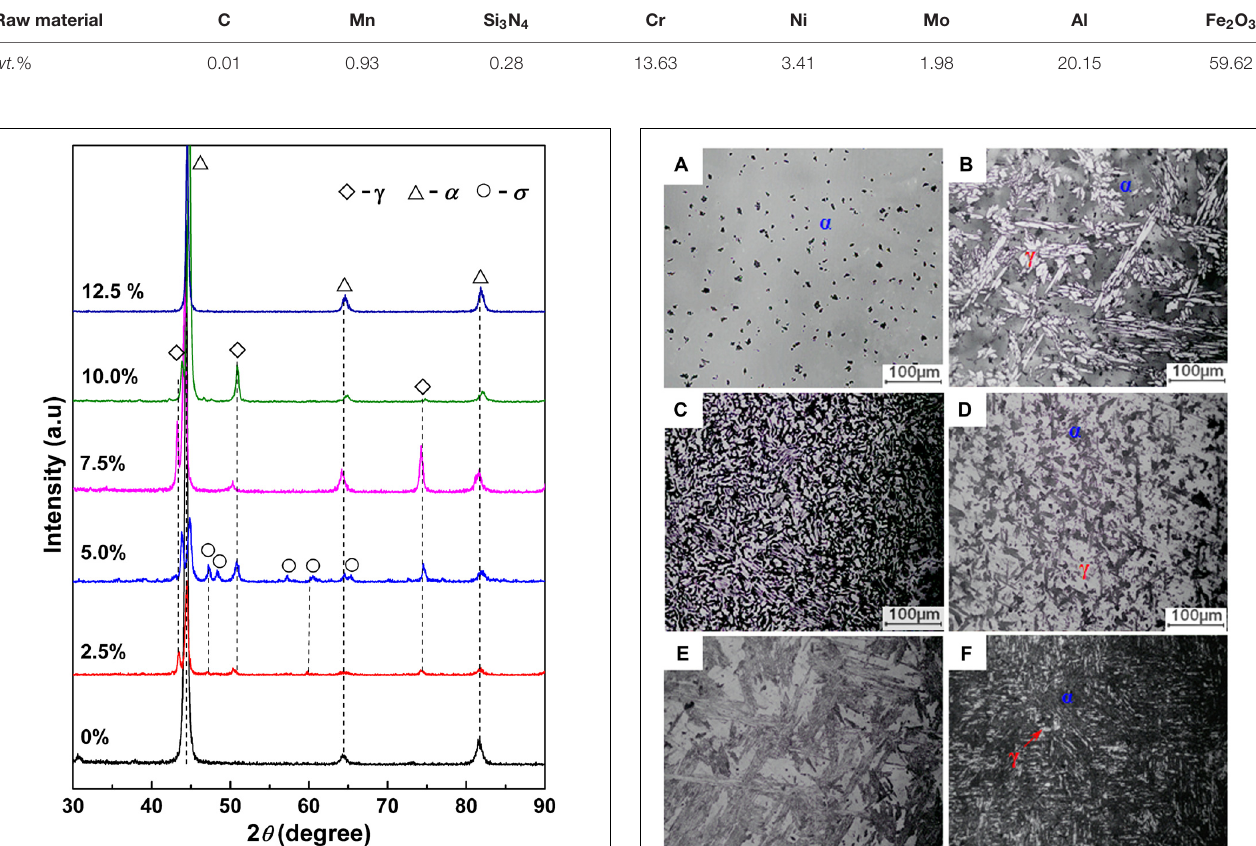
TABLE 1 | Standard proportion of 2205 DSS reaction raw materials.